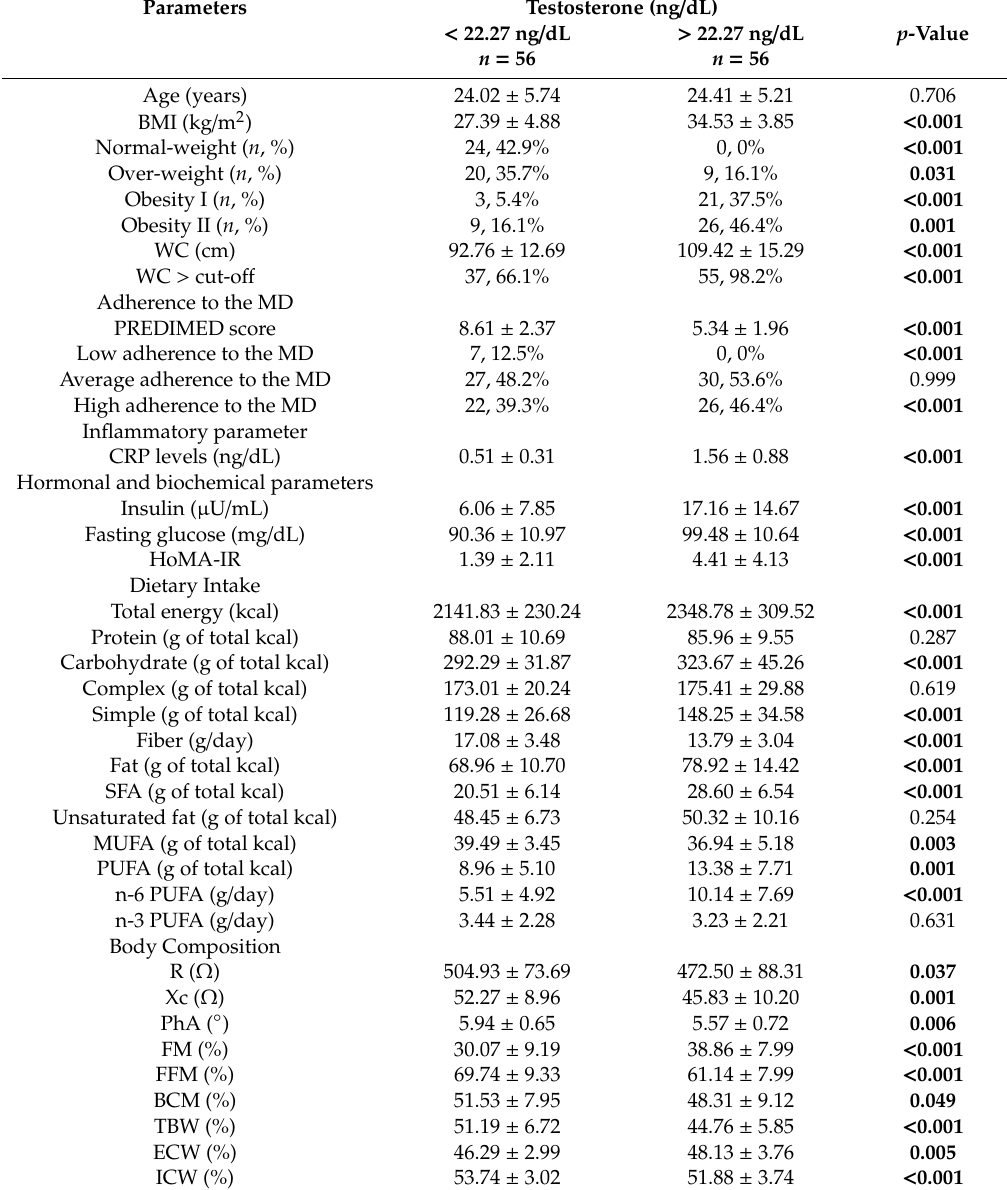
Table 4. Age, anthropometric measurements, adherence to the MD, inflammatory parameter, dietary intake and body composition of the case-patients above and below the median of